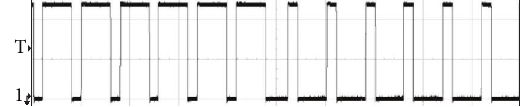
Figure 3: Oscilloscope capture of the B-PWM waveform at the output of the transmitter, similar to the one of Figure